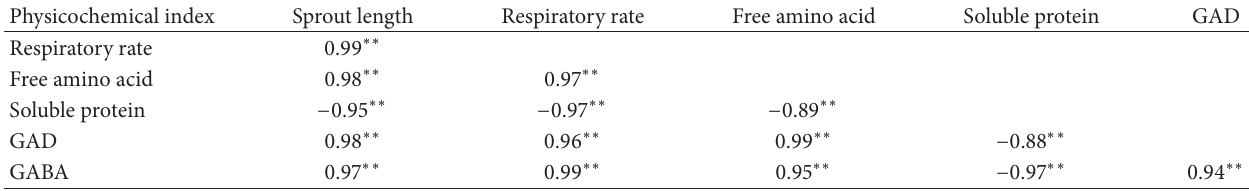
Table 2: Correlation analysis among physiological activity, GABA, and other essential substances in germinated tartary